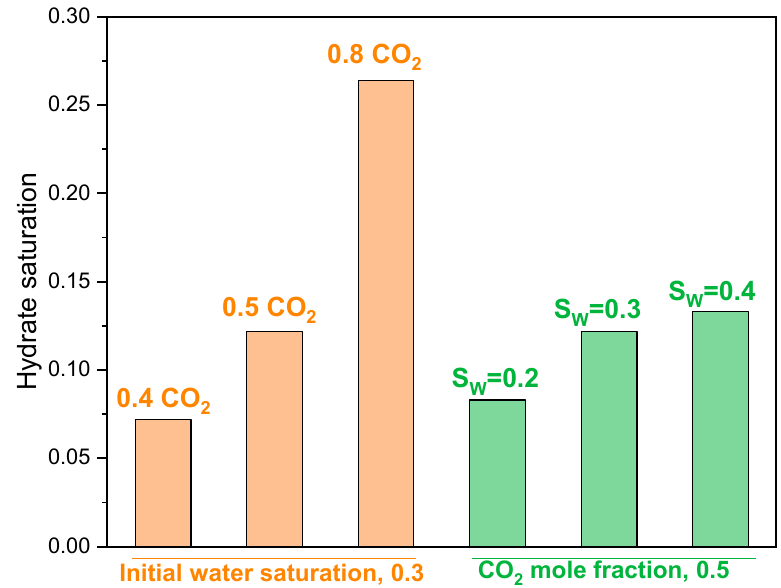
Figure 3. Hydrate saturation under different experimental conditions.